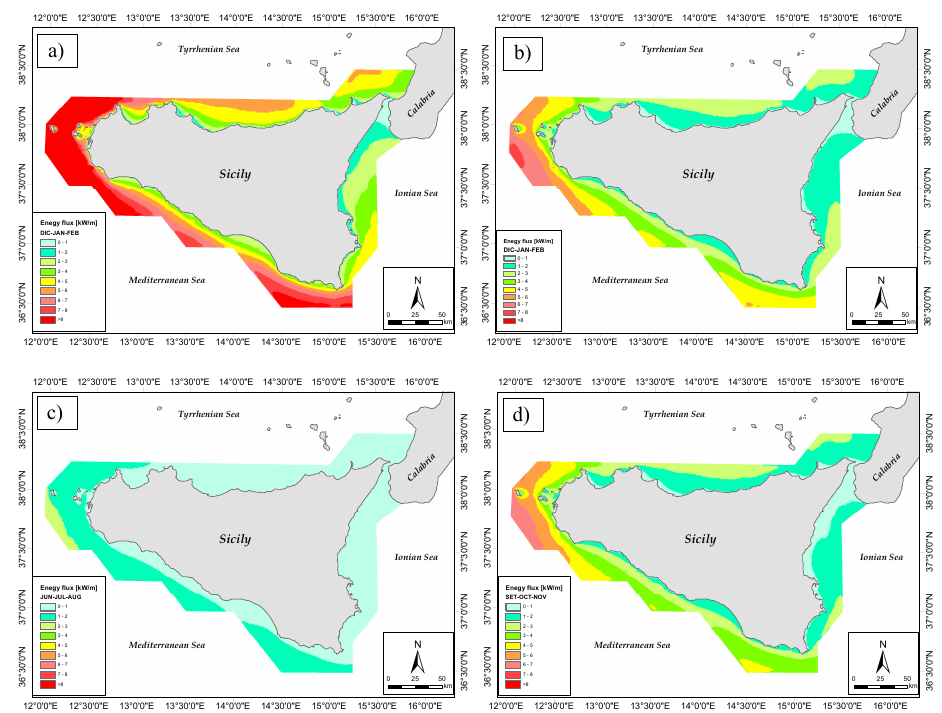
Figure 9. Seasonal distribution of the average wave energy flux per unit crest length within the computational domain. (a) December, January and February; (b) March, April and May; (c) June, July and August; (d) September, October and November.